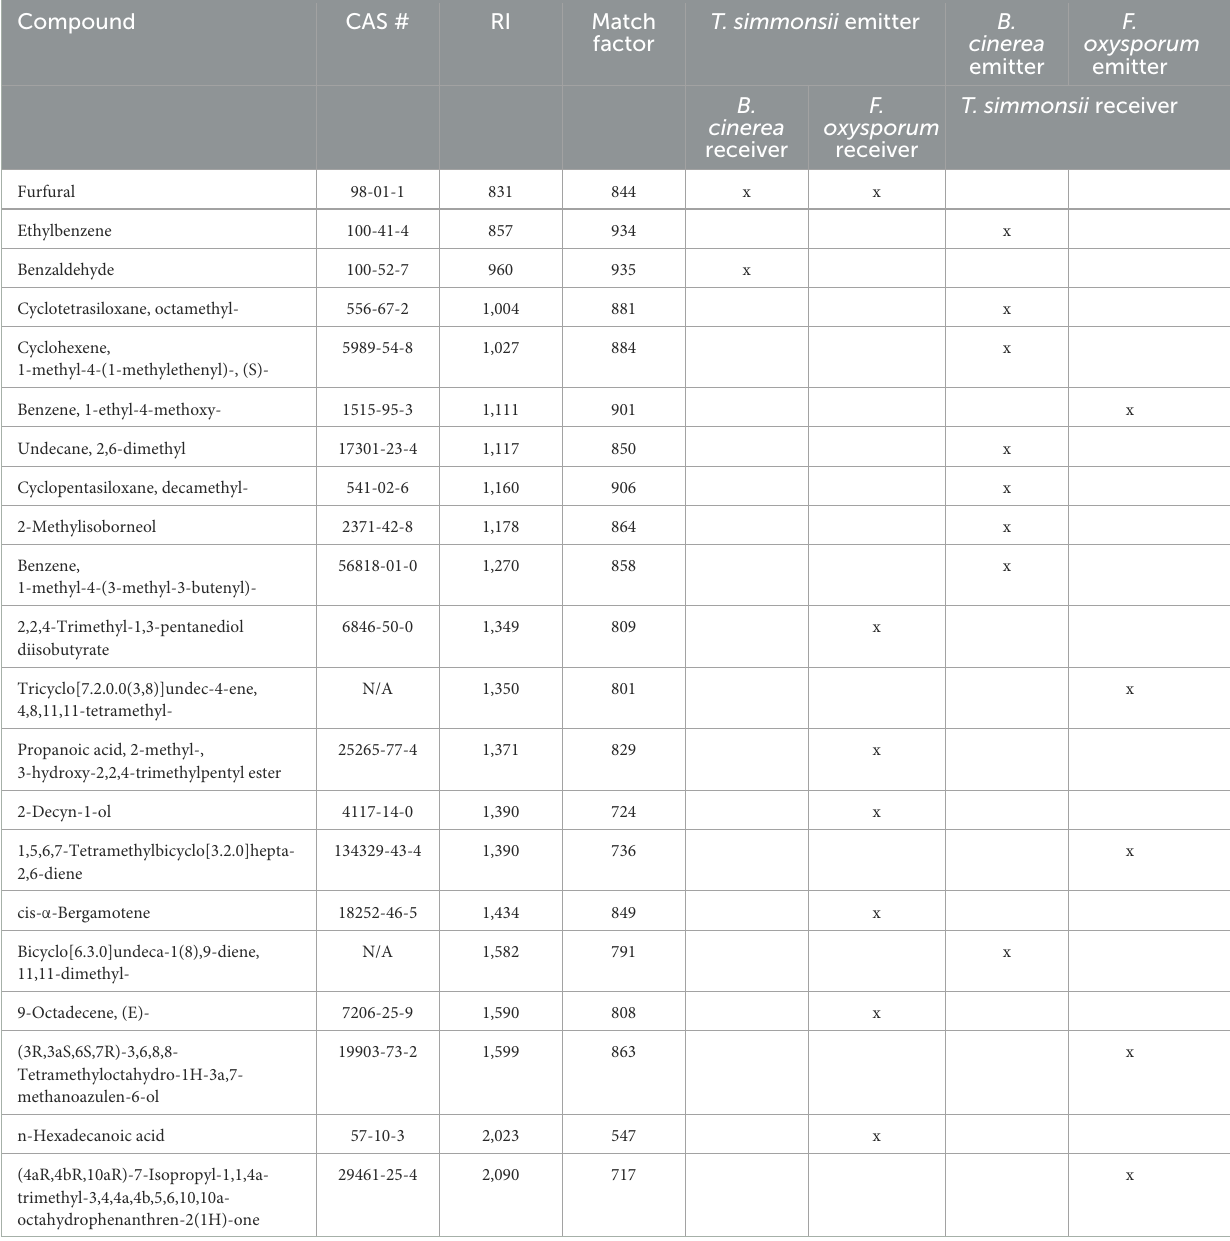
TABLE 2 Volatiles produced by the emitter fungi and not detected in exposed samples.